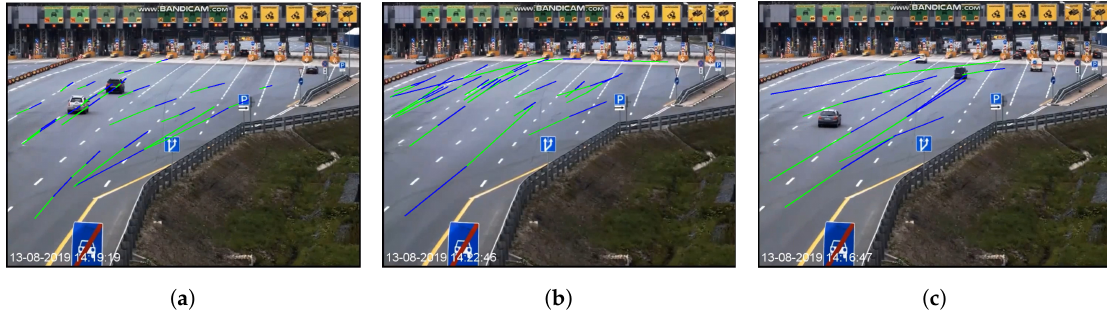
Figure 11. Prediction model visualizing the driving paths at a toll station. ( a – c ) have request intervals set at 500 ms, 1000 ms and 1500 ms, respectively.